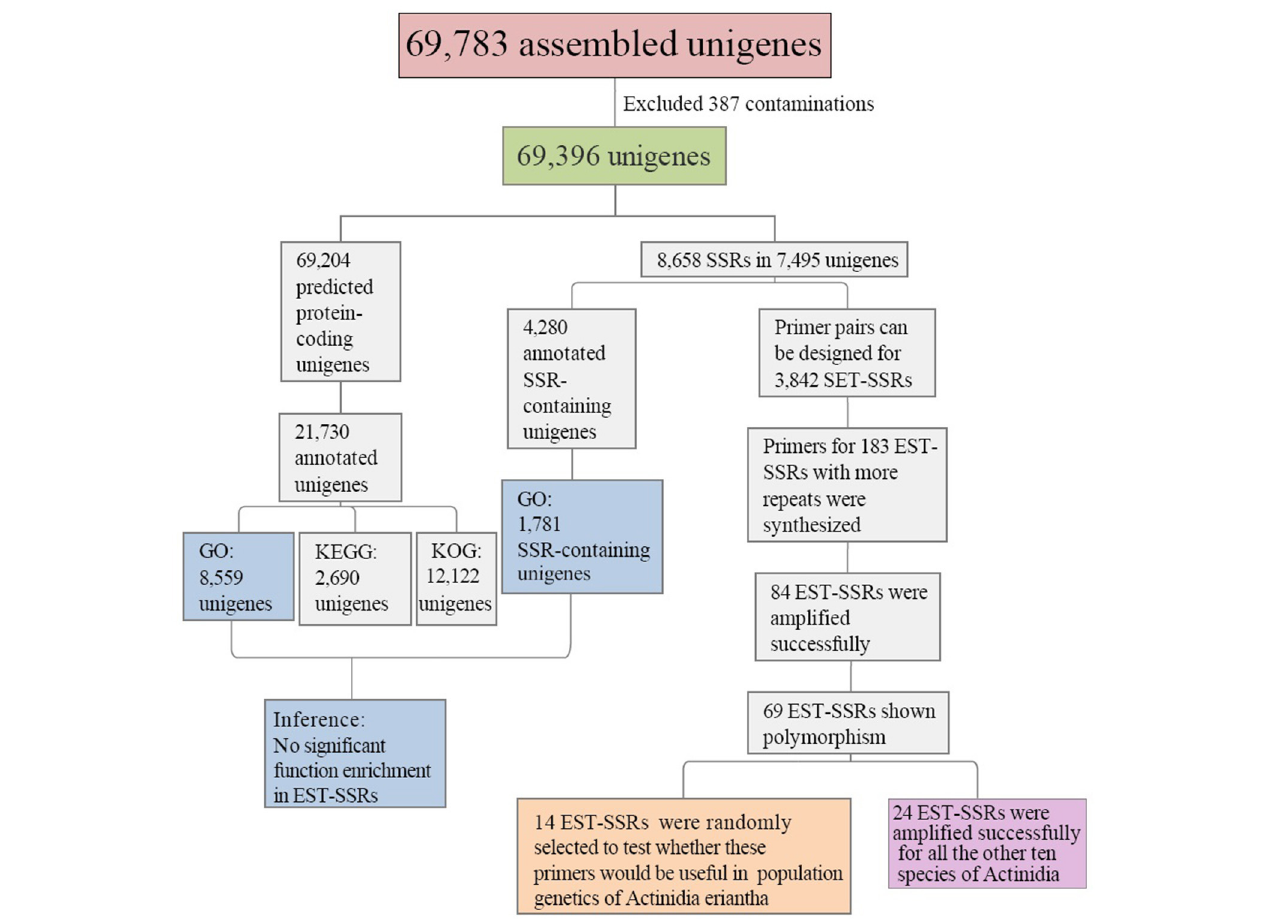
FIGURE 1 | Outline of the process of unigene annotation and EST-SSR development in Actinidia eriantha.